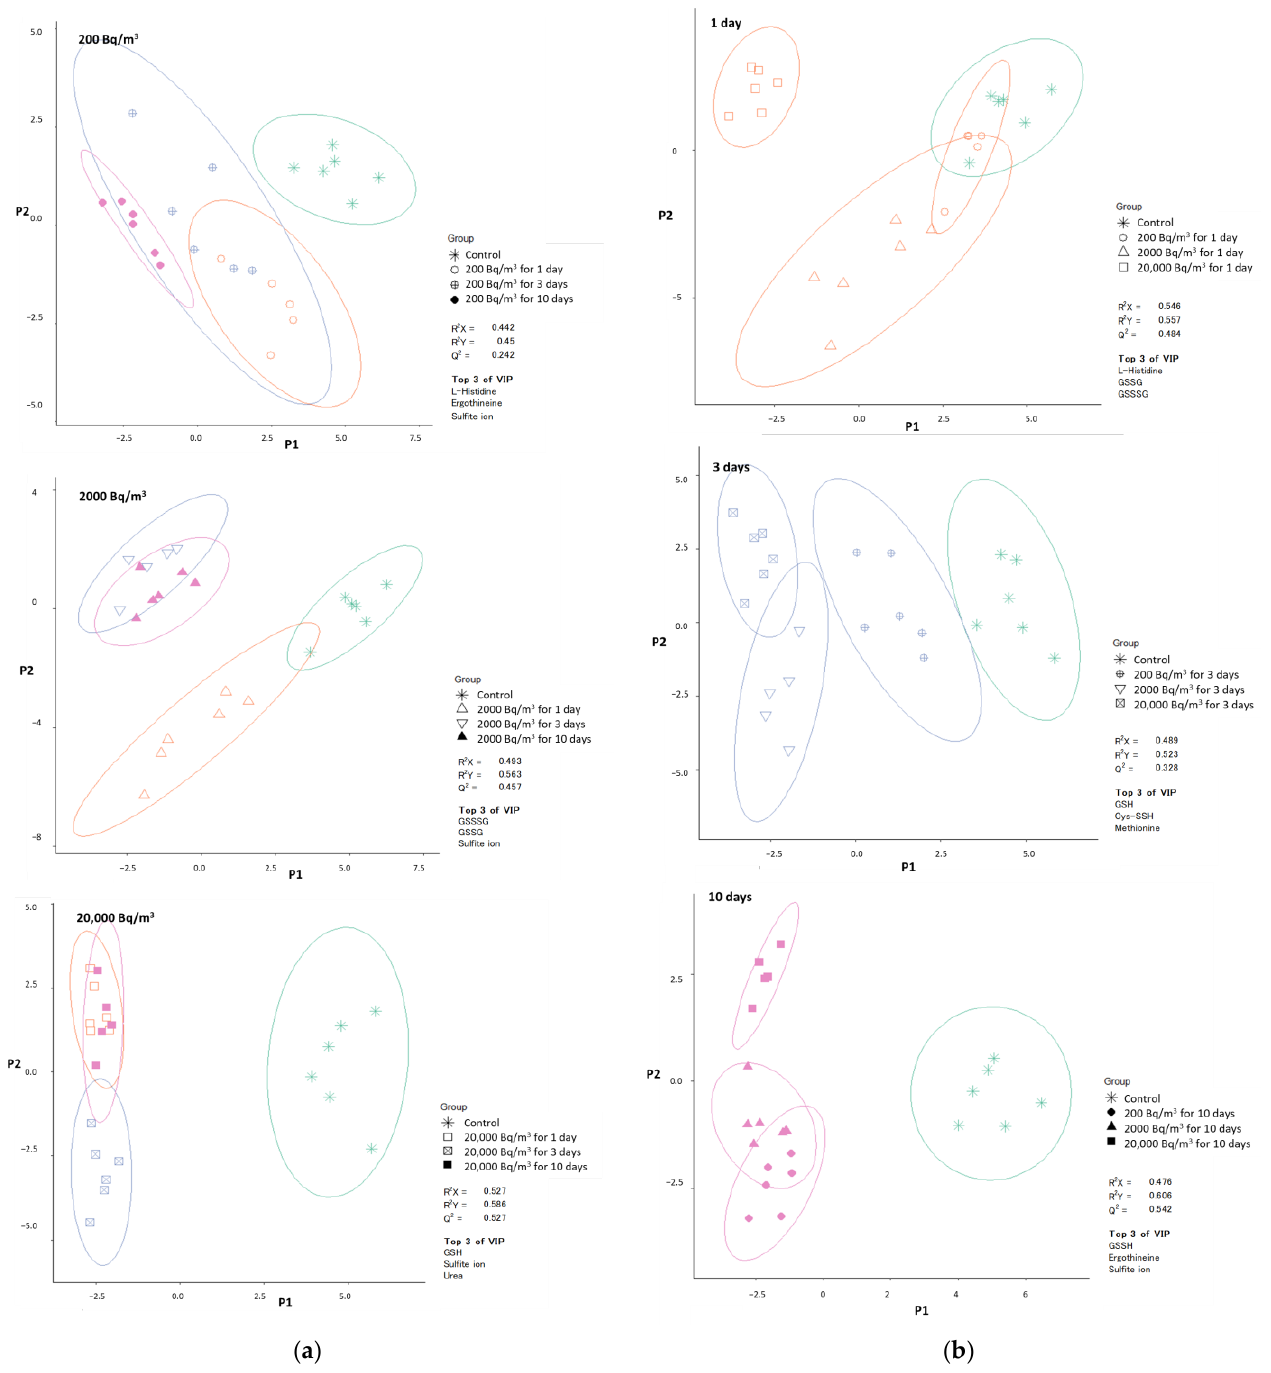
Figure 7. Clustering by PLS-DA. PLS-DA was performed by ( a ) radon concentration or ( b ) radon inhalation time.